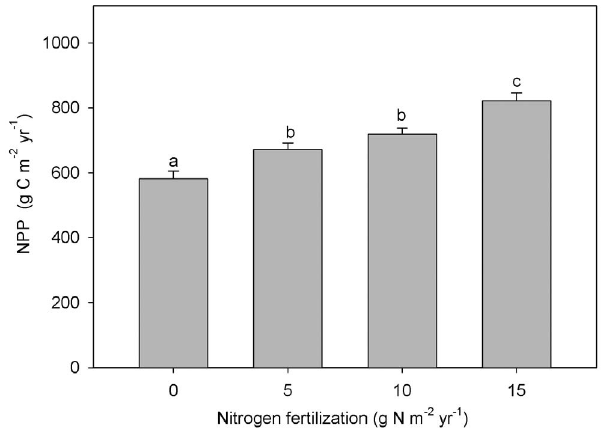
Figure 1. Average net primary productivity (NPP) in control and nitrogen (N) fertilized treatments. Significant differences among N treatments are indicated by different letters.